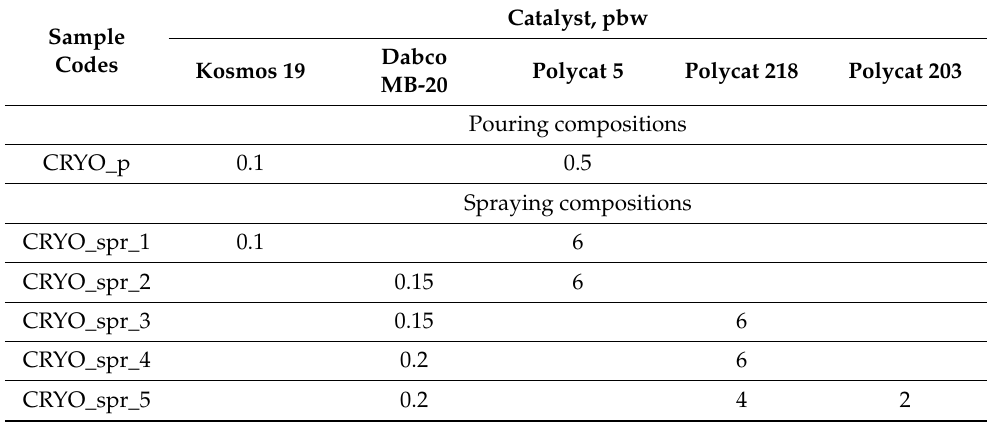
Table 2. Catalyst package and sample codes for PUR